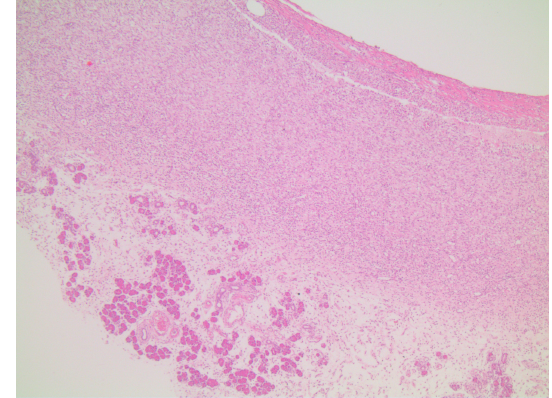
Figure 4. TNBS group on day 7, transmural inflammation, fibrosis, and adherence to pancreas (H&E, × 40). H&E, hematoxylin and eosin; TNBS, trinitrobenzene sulphonic